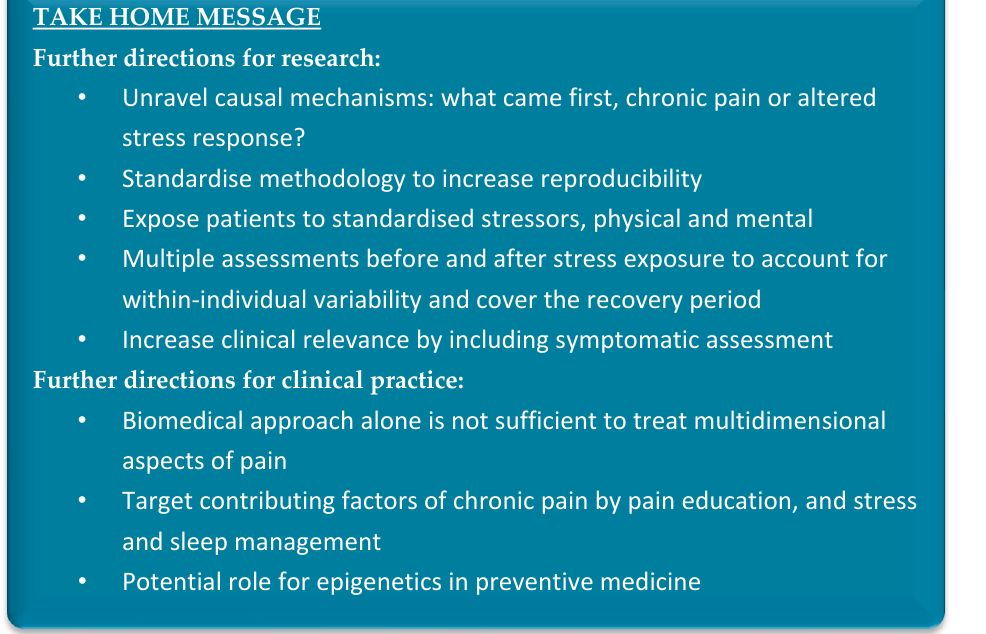
Figure 2. Summary of future directions for research and clinical practice.